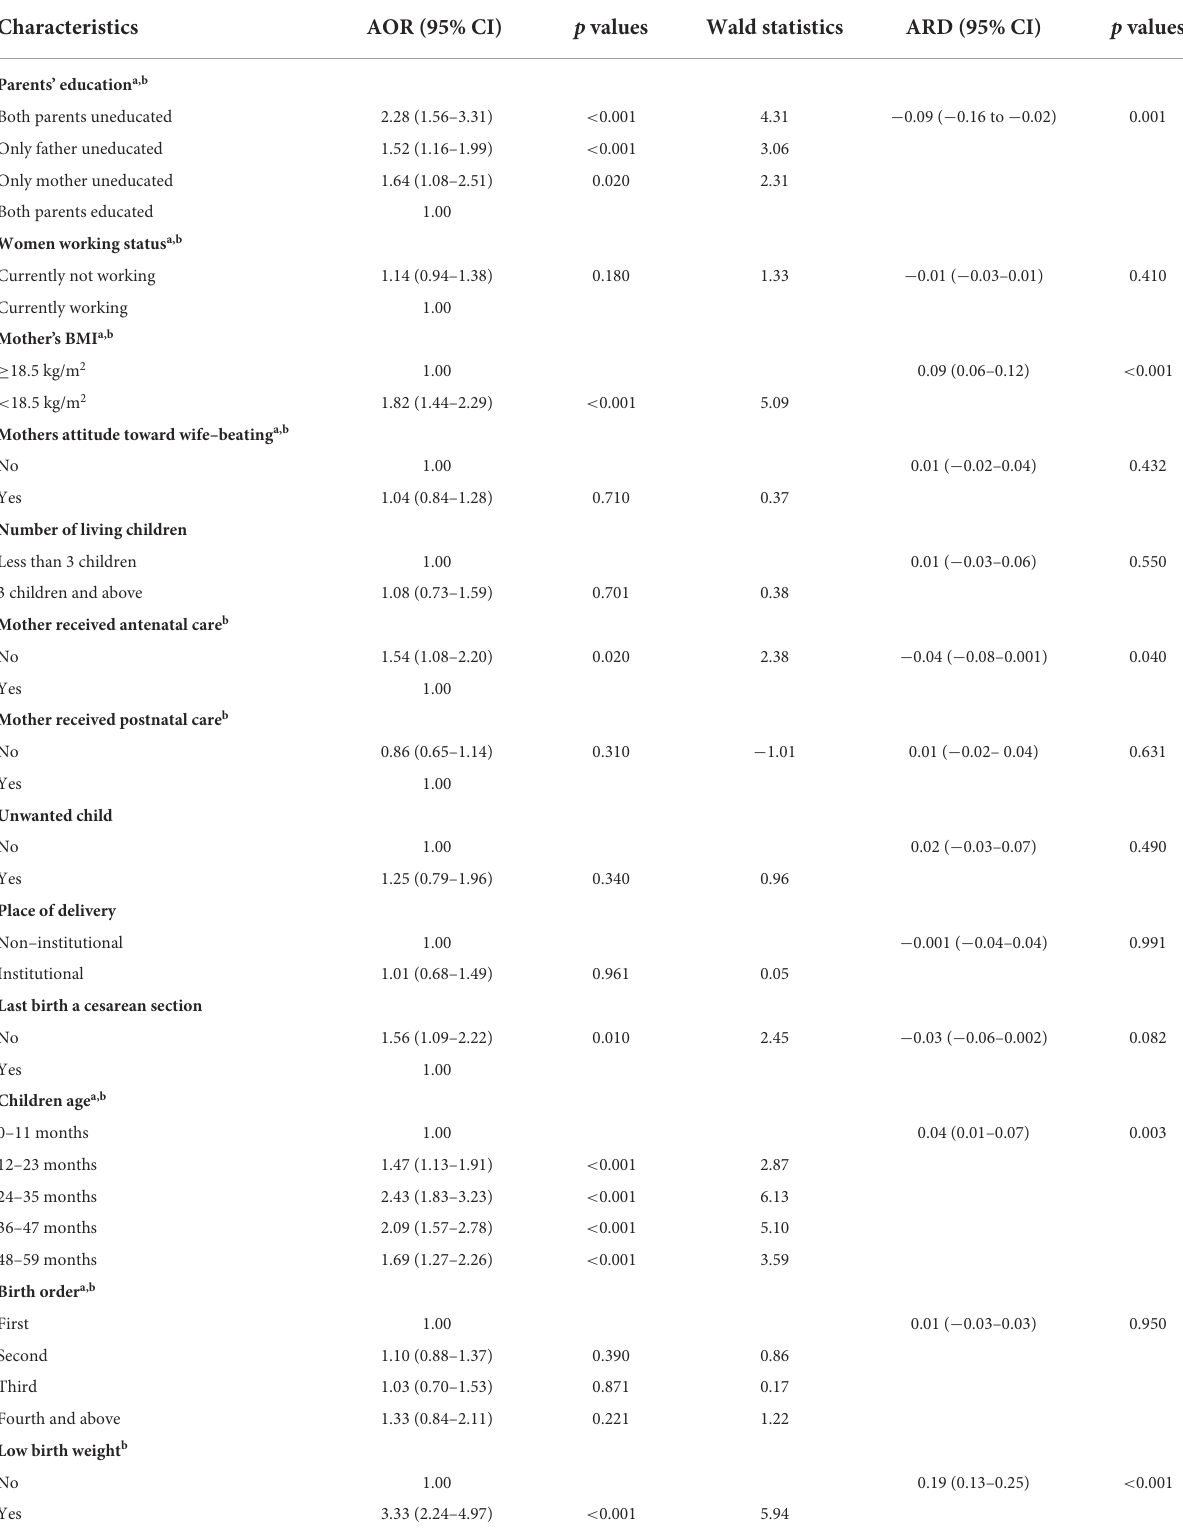
TABLE 4 Factors associated with SAF among under-5